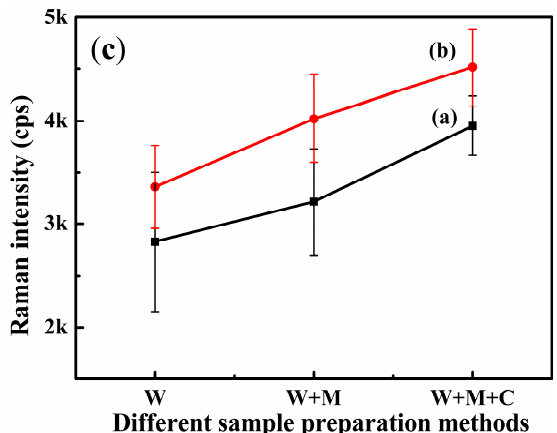
Figure 5. ( a ) Surface-enhanced Raman scattering (SERS) spectra extract from large yellow croaker peels spiked with 509.55 ng/cm 2 of tartrazine; ( b ) extract added with tartrazine equivalent (a) but assumed 100% recovery rate; ( c ) Raman intensity of tartrazine at 1599 cm − 1 via different sample preparation methods ( n = 20).